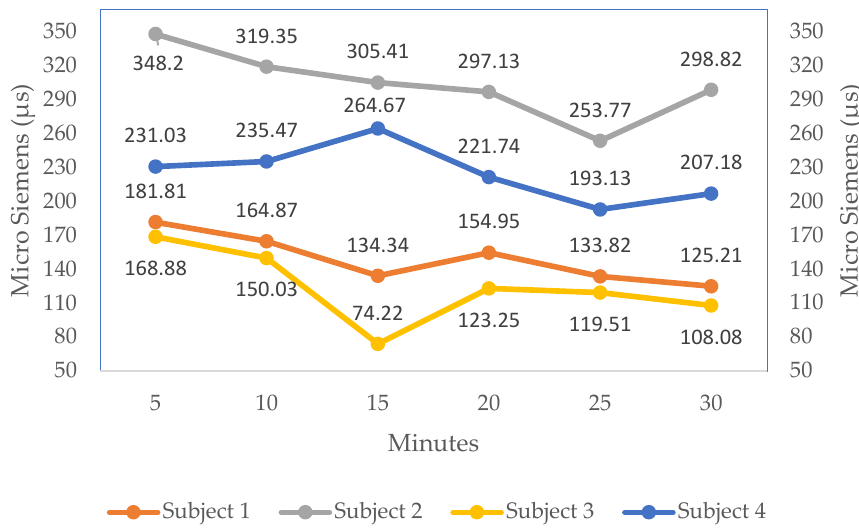
Figure 13. Skin conductance graph of the first four subjects.